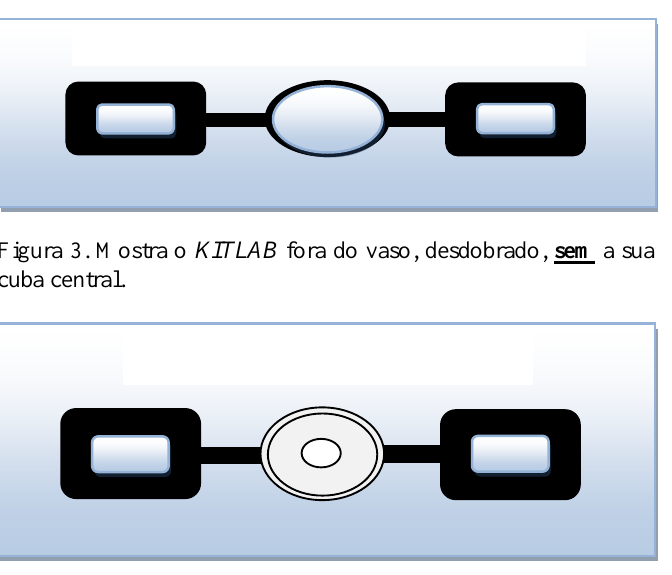
Figura 4. Mostra o KITLAB fora do vaso, desdobrado, com a sua cuba central.